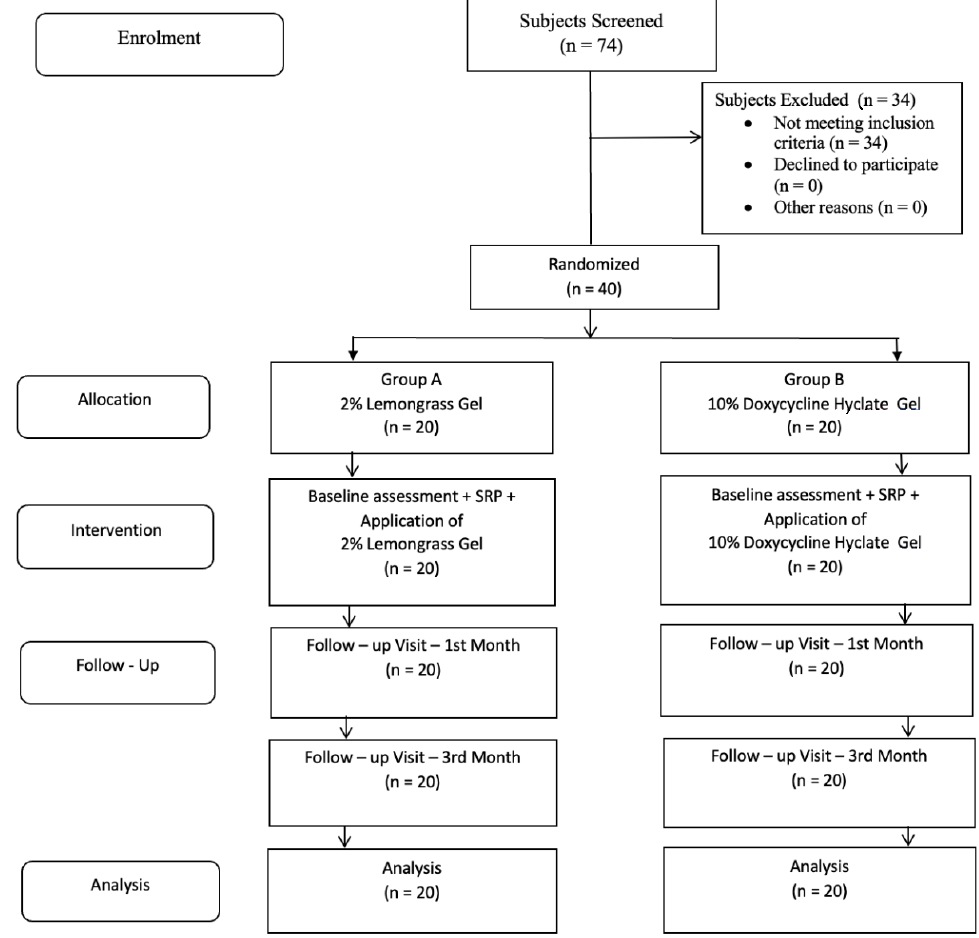
Figure 2. Flow chart of the